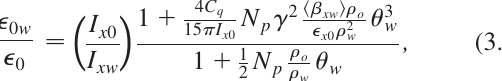
(right) generated 4